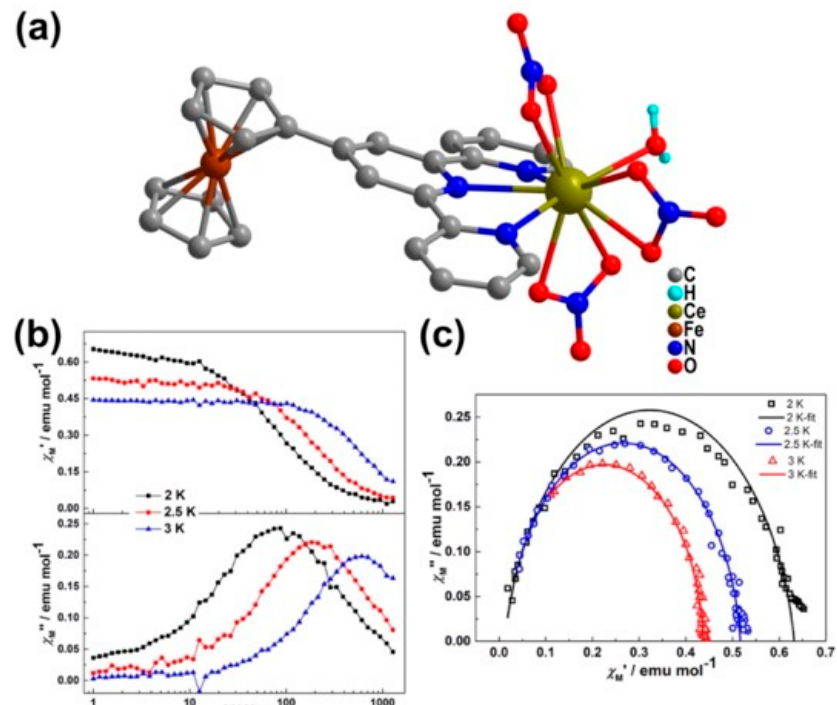
Figure 14. ( a ) Molecular structure of 26 , ( b ) frequency dependence of the in-phase ( χ ′ ) (top) and out- of-phase ( χ ” M ) (bottom) magnetic susceptibility of 26 between 2 and 3 K under 2 kOe, ( c ) Cole–Cole plots of 26 between 2 K (black) and 3 K (red) (the solid lines represent the best fits as calculated with an extended Debye model). Figures and captions are reproduced from Reference [49] with permission from Elsevier Ltd.